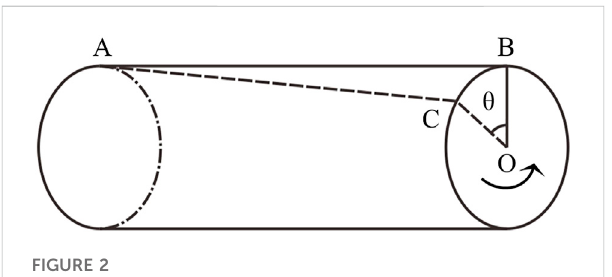
FIGURE 2 Schematic diagram of the sensor at a torsion angle θ